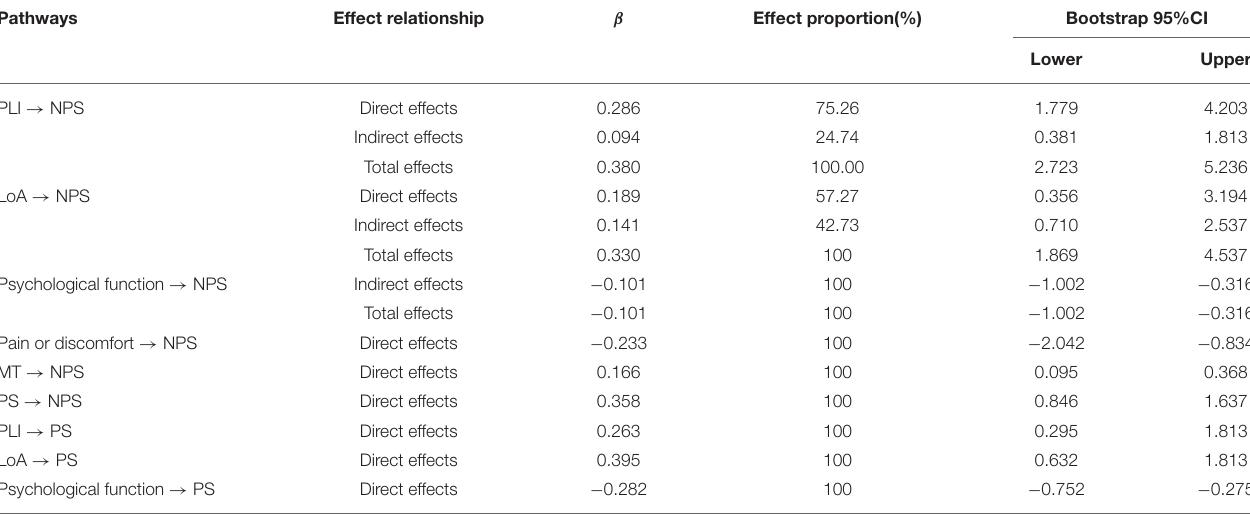
TABLE 5 | Standardized direct, indirect and total effects of the variables.